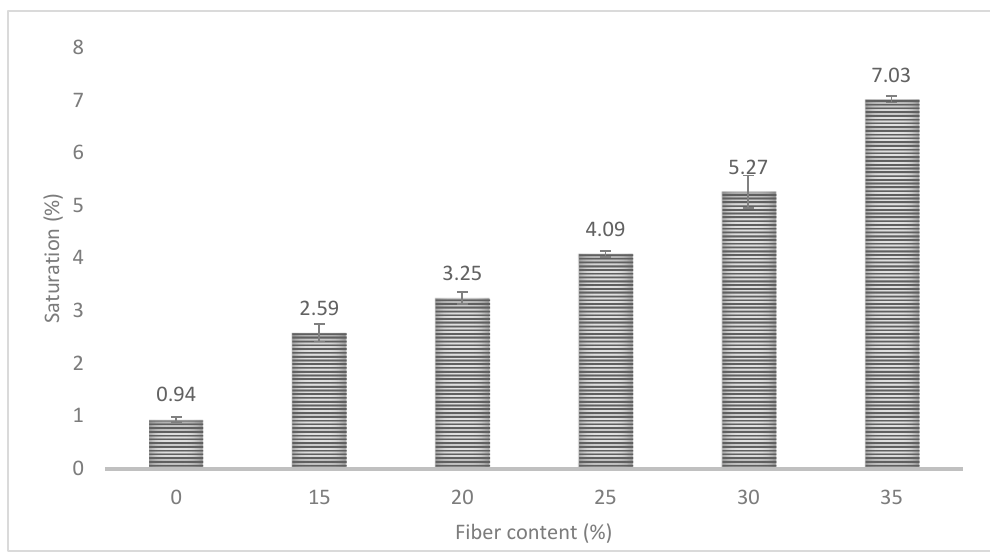
Figure 8. Water uptake of PLA and PLA-BKSP composite materials in the saturation stage.